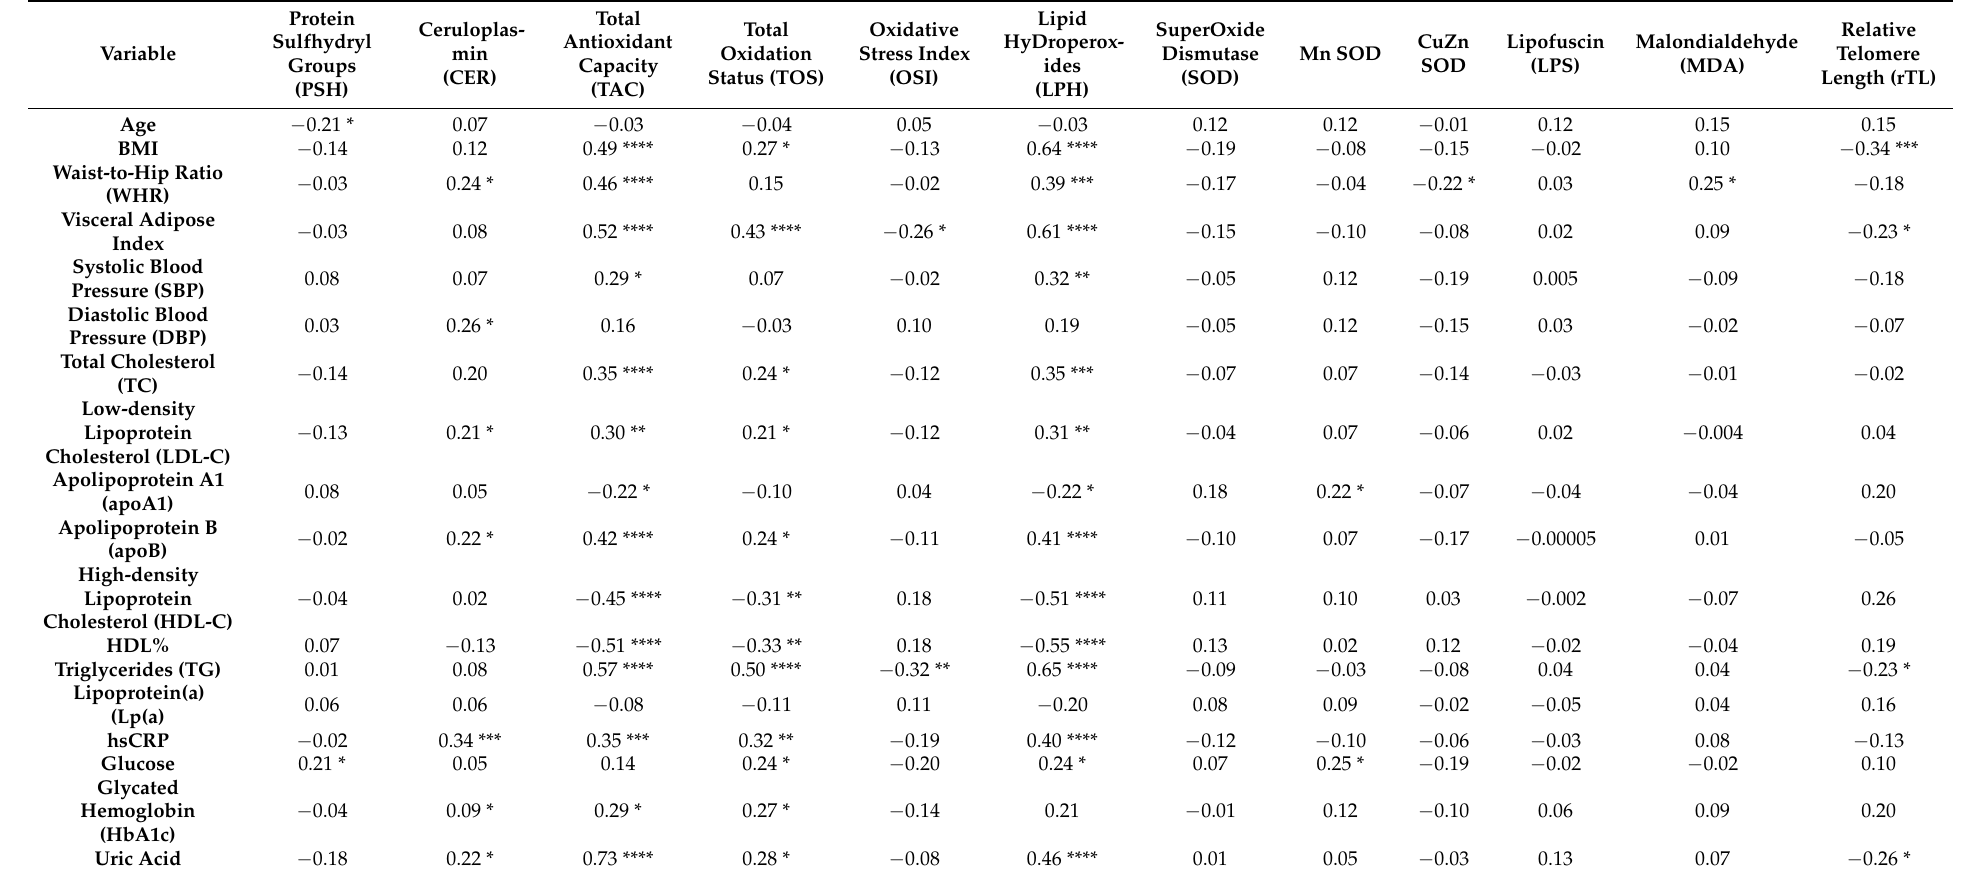
Table 4. Correlations between oxidative stress parameters and age, anthropometric measurements and other laboratory